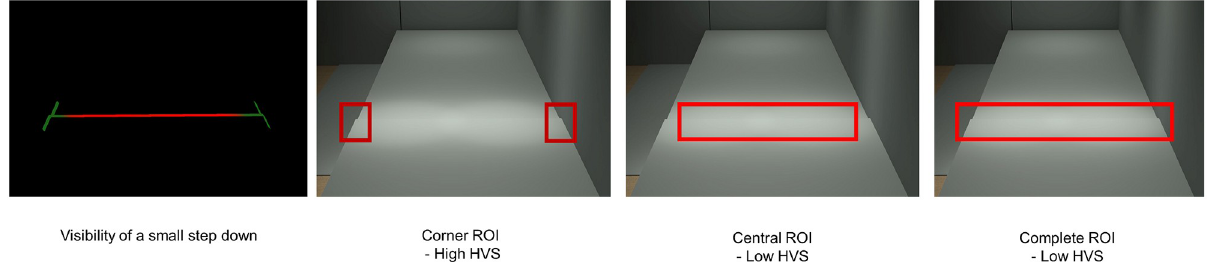
Fig 10. ROI’s influence on visibility estimation. A small downward step is shown in original resolution with three different definitions of ROI. From left to right, the first panel visualizes the visibility of the step with VA equivalent to 1.15 logMAR and CS 0.85 Pelli-Robson. Within this step, the left and right corners (green part) have high visibility, whereas the central horizontal edge (red part) has low visibility. The ROI can be defined as the side corners (second panel), or the central horizontal edge (third panel), or the whole step (fourth panel). The HVS derived from the corners ROI is 0.889, central ROI 0.051, while the ROI based on the entire step had HVS of 0.106. The definition of ROI will often lead to a significant change in